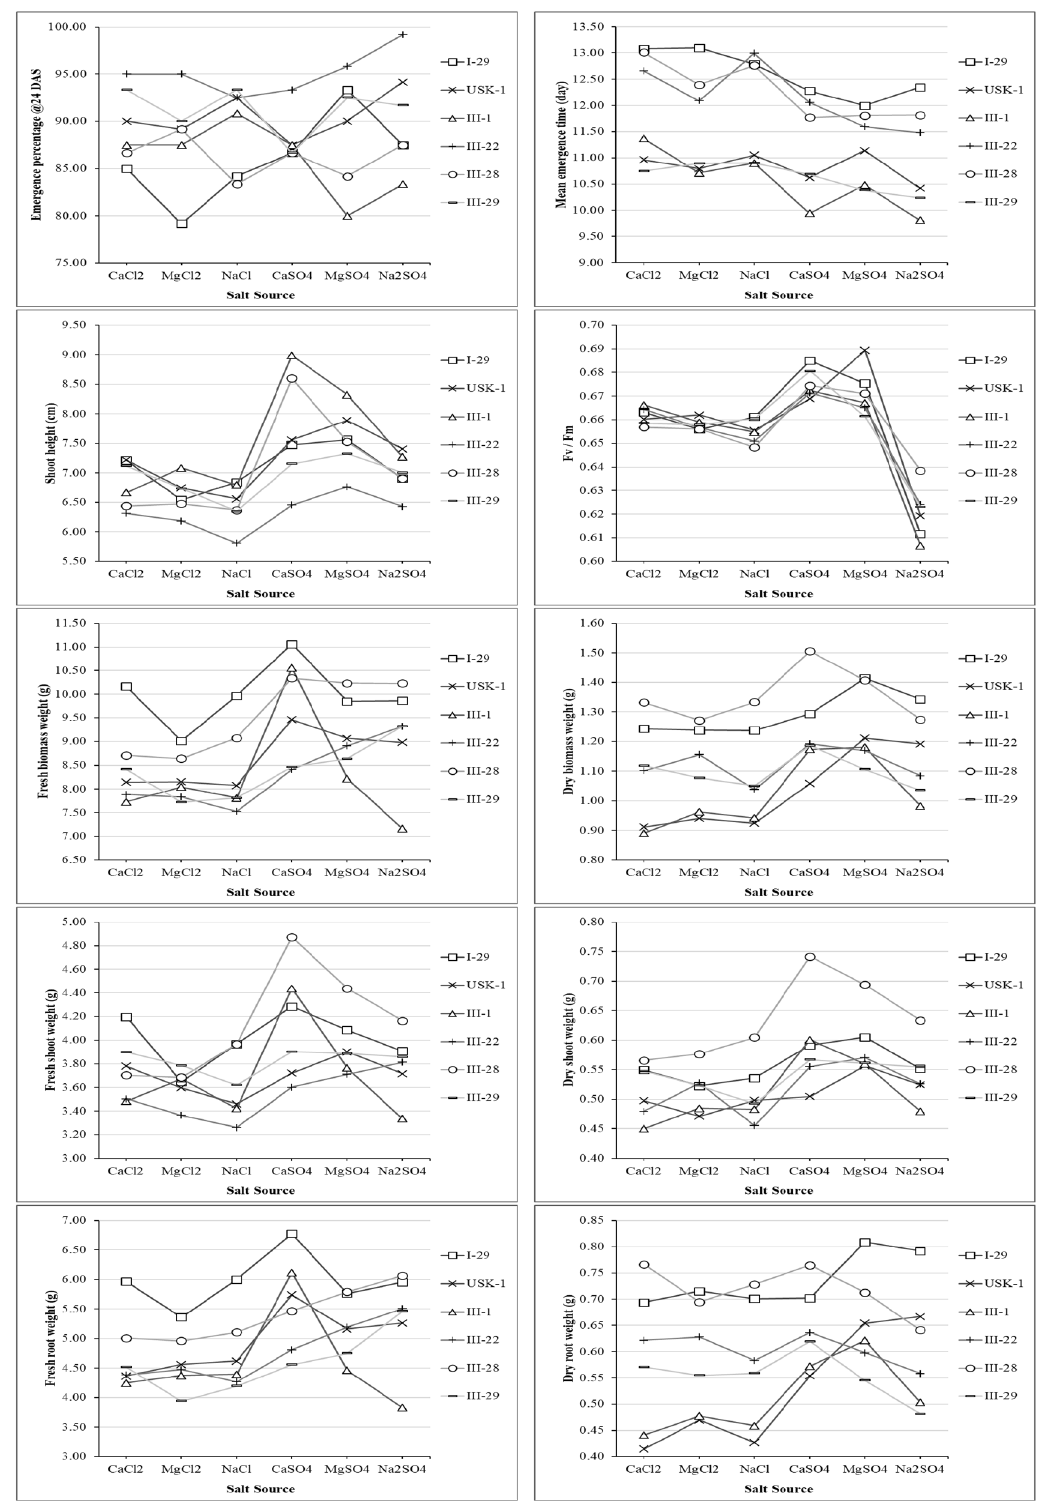
Figure 2. Comparison of faba bean genotypes under the main effect of salinity